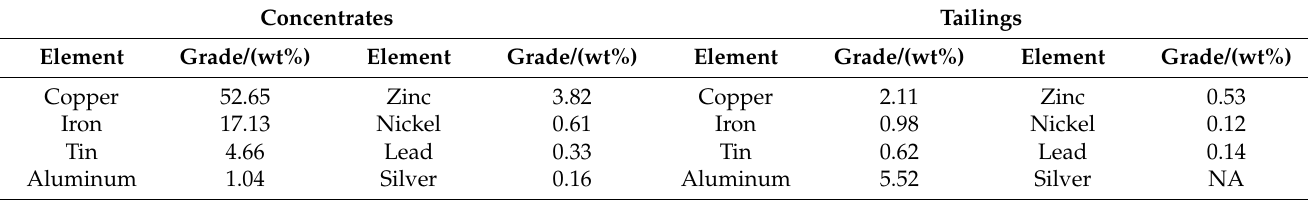
Table 5. The elements distribution of concentrates and tailings of enhanced gravity